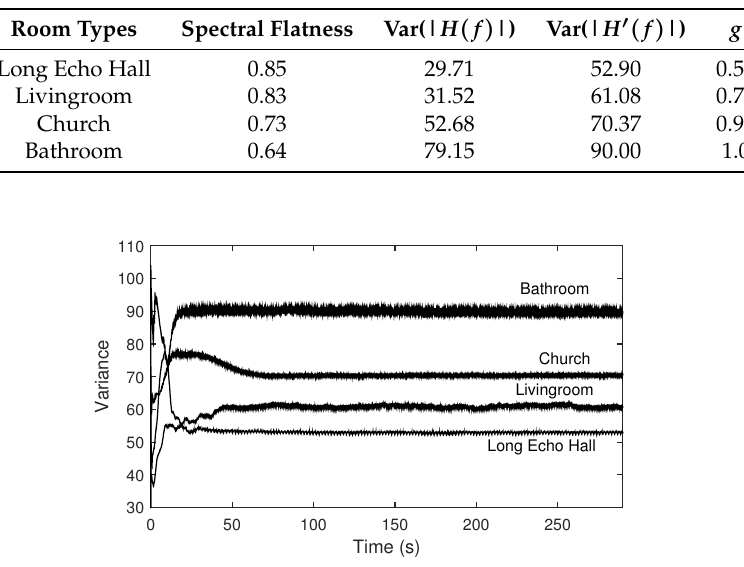
Table 3. Comparison of the distributions of room modes measured by spectral flatness and variance of the magnitudes of the impulse response data ( H ( f ) ), average variance of the frequency magnitudes of the estimated transfer function ( H (cid:48) ( f ) ), and average gain values mapped by H (cid:48) ( f ) ( g ).